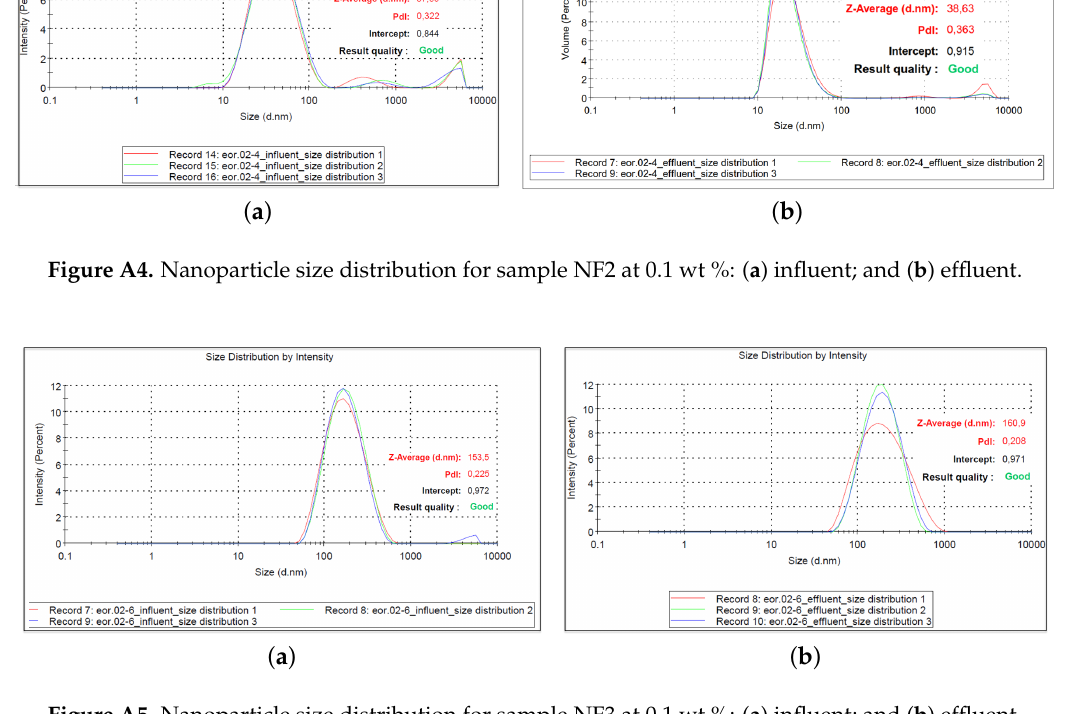
Figure A5. Nanoparticle size distribution for sample NF3 at 0.1 wt %: ( a ) influent; and ( b ) effluent.